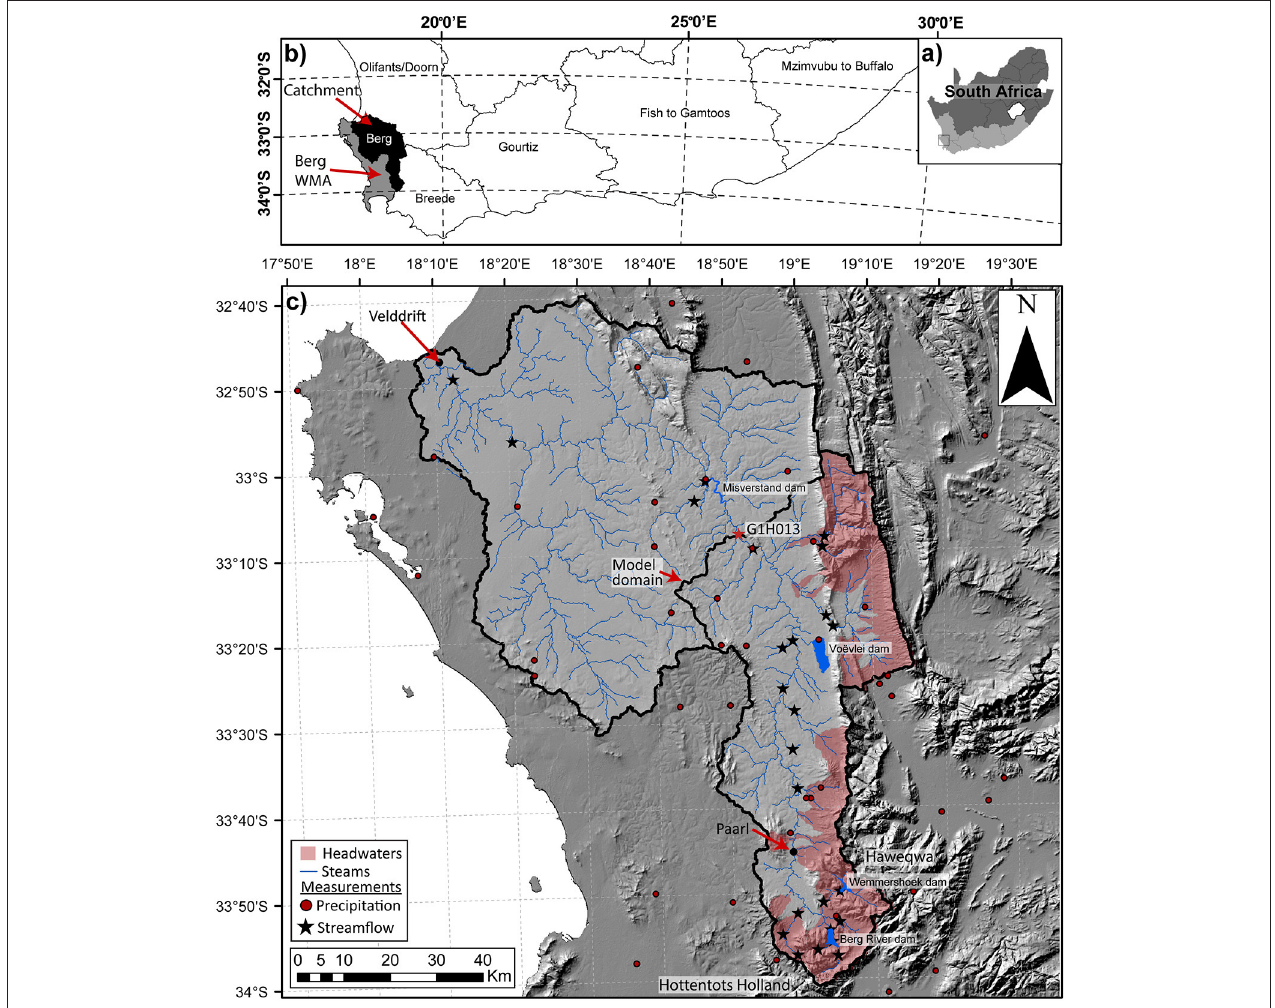
FIGURE 2 | (a) Location of the Western Cape (WC) within South Africa, (b) Berg River Water Management Area (WMA) surrounded by other WMA’s within the WC (Breede, Olifants/doorn), (c) Berg River catchment showing locations of precipitation stations (red points), streamflow monitoring (black star), G1H013 gauge (red-star), the modeling domain and locations of major towns, reservoirs (Berg River, Wemmershoek, Voëlvlei and Misverstand dams), the major town of Paarl in context with the mountain ranges of the Hawequa and Hottentots Holland and headwater areas ( > 300M A.S.L: red